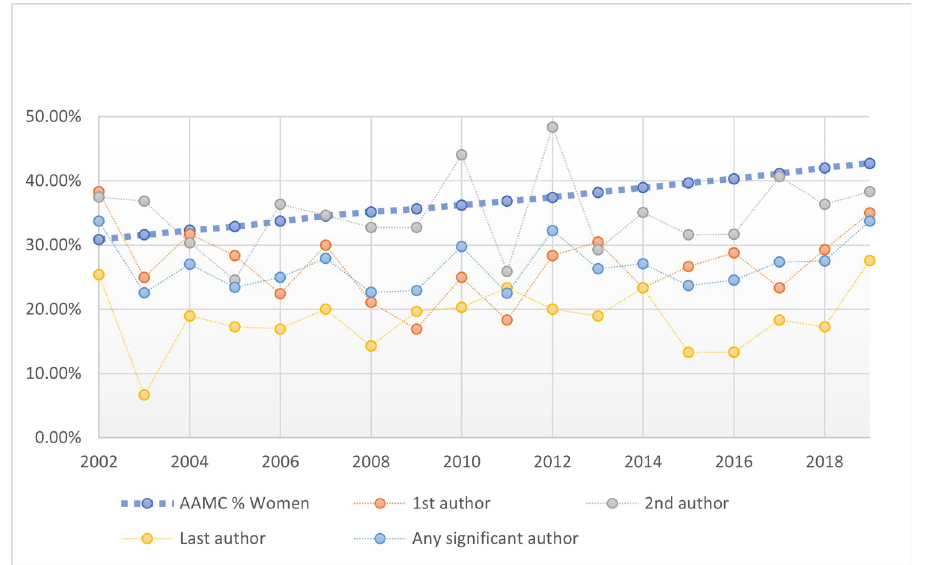
Fig 6. Comparison of women author rates by author role by year with AAMC